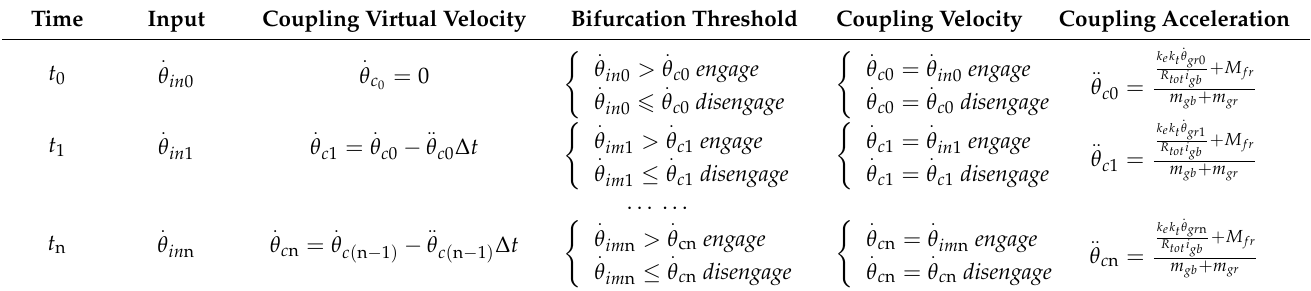
Table 2. Numerical iterative motion bifurcation